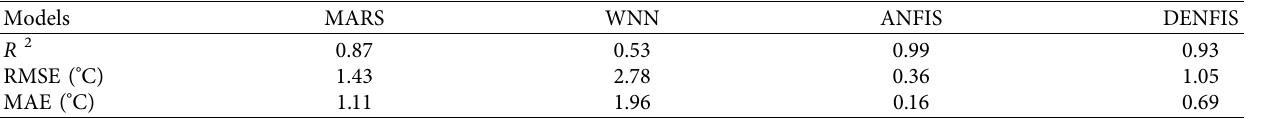
Figure 12: Testing performance for (a) MARS, (b) WNN, (c) ANFIS, and (d) Table 8: Testing stage performance analysis.